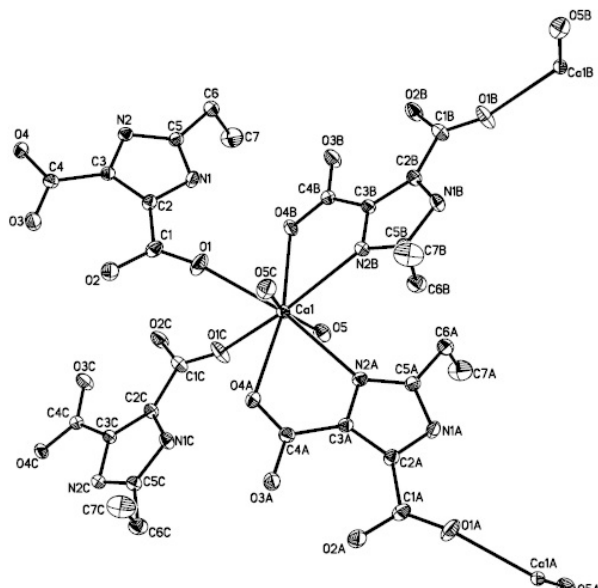
Table 1. Data collection and handling.